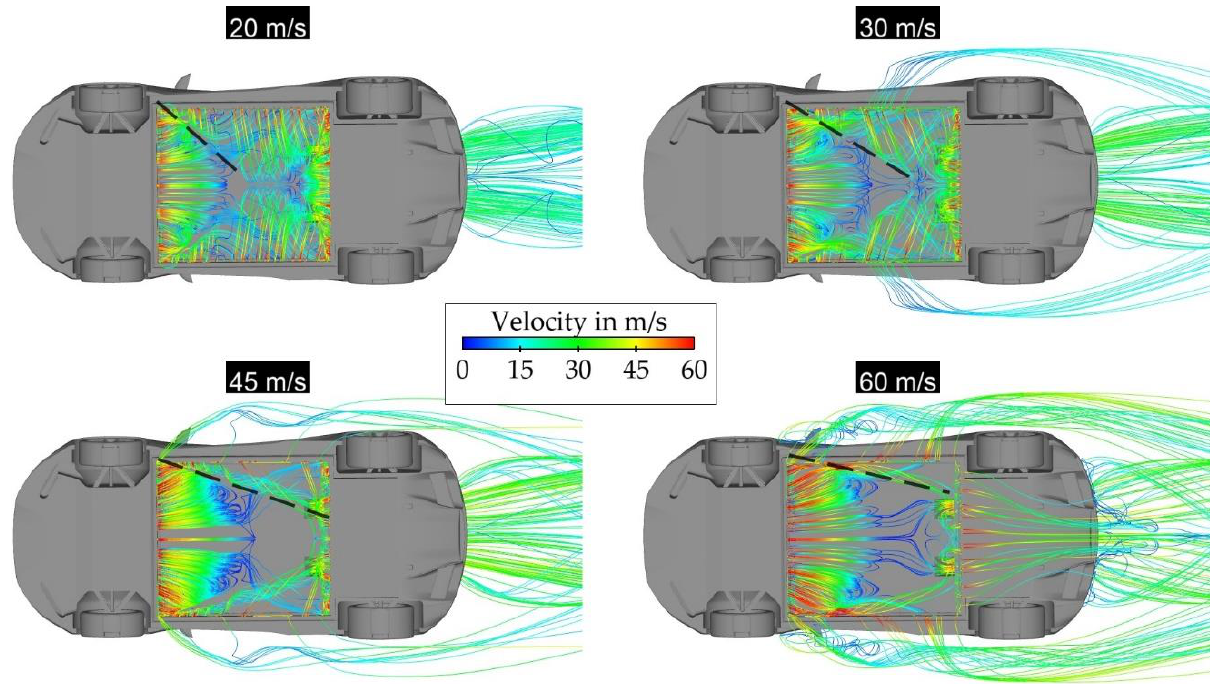
Figure 33. Pathlines released from nozzles for various inlet velocities. The border between pathlines released from the front and side curtains was marked with a dashed line.